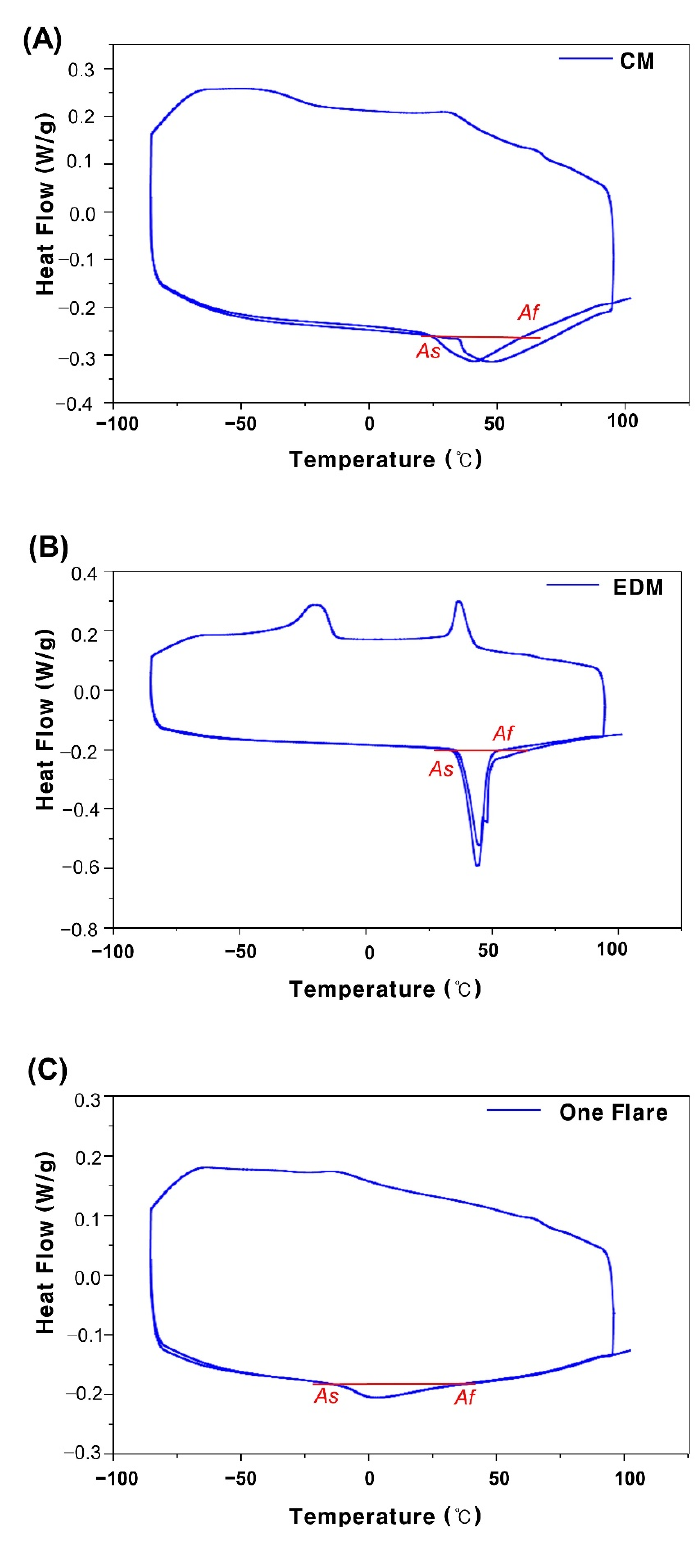
Figure 3. Representative DSC results of HyFlex CM ( A ), HyFlex EDM ( B ), and OneFlare ( C ). The lower curve is the heating cycle and the upper curve is the cooling cycle. The austenite start temperature (As) and austenite finish temperature (Af) are shown in the heating curve.